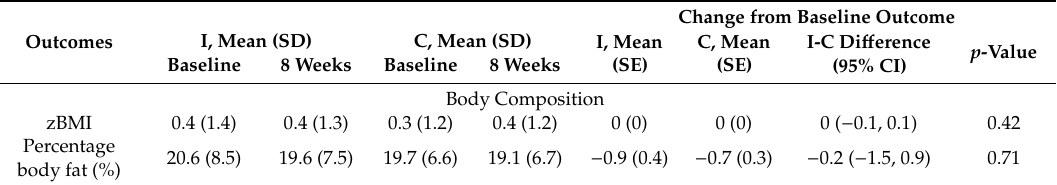
Table 3. Estimated Treatment E ff ects on Body Composition.